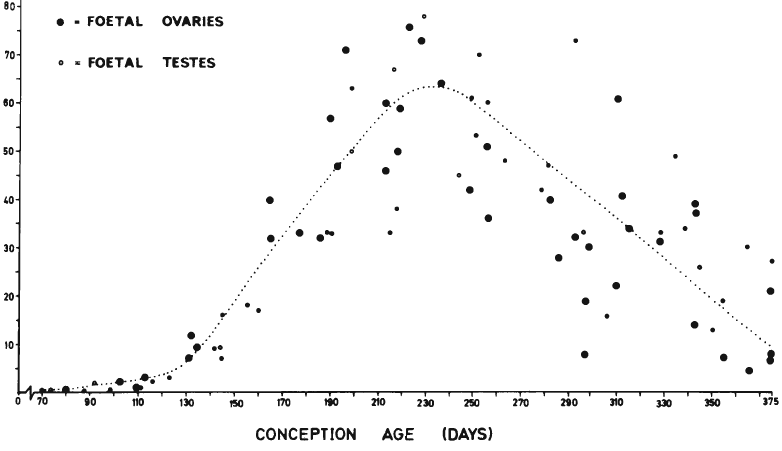
Fig. 9. Scatter diagram illustrating changes in the mass of paired Burchell's zebra ovaries during pregnancy. Average results for the 19 arbitrary phases of pregnancy given in Table 10 are also illustrated (closed circles). The curve was fitted by eye.